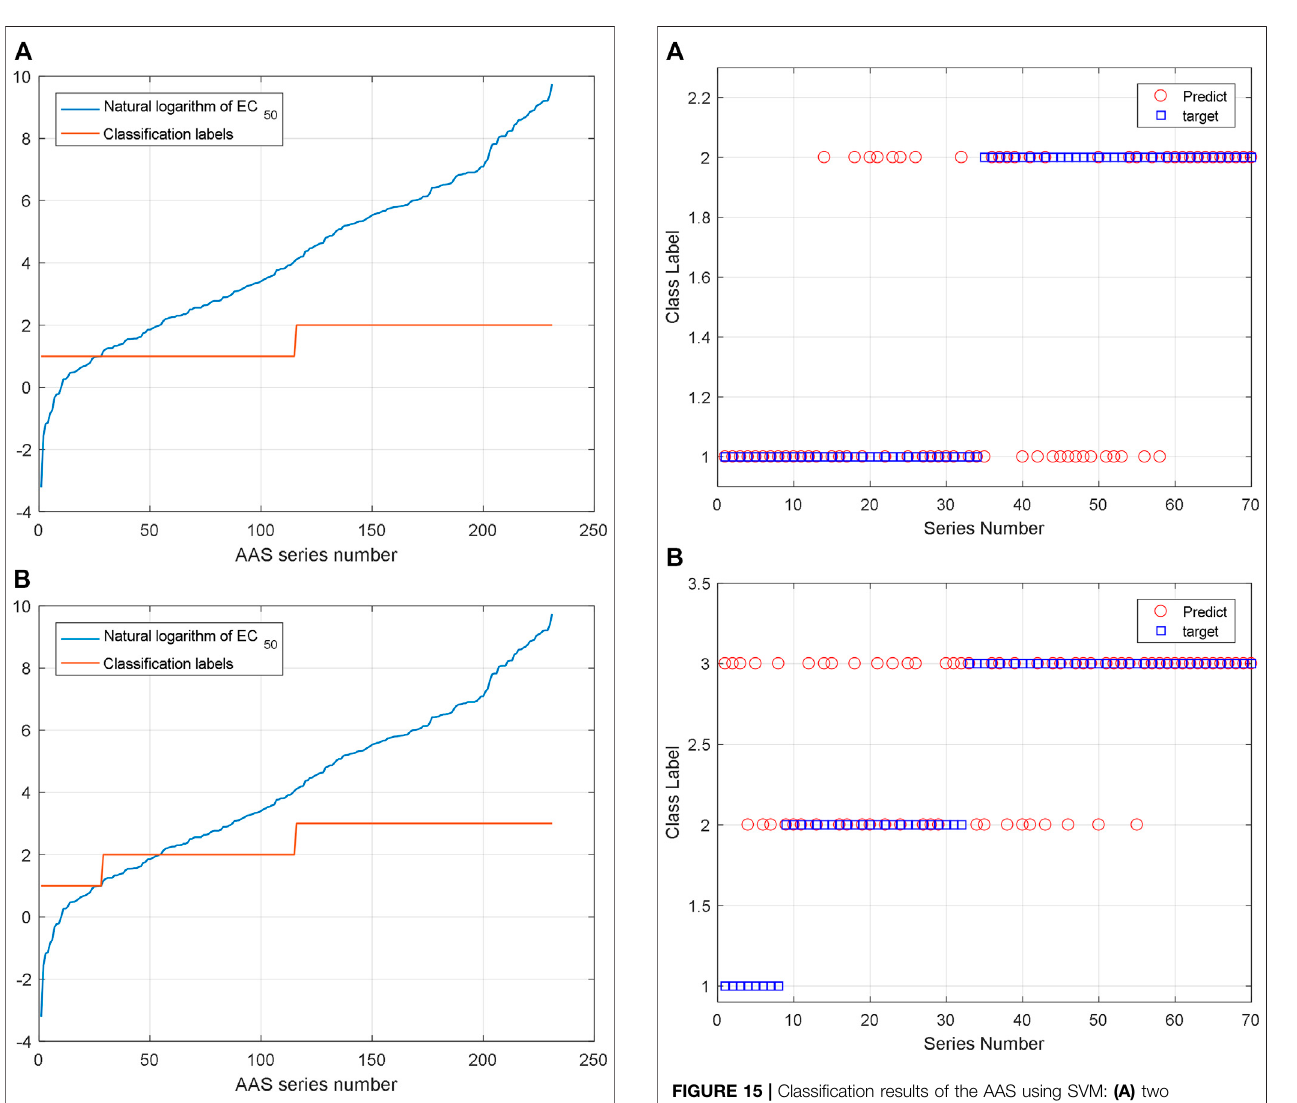
FIGURE 15 | Classi fi cation results of the AAS using SVM: (A) two classi fi cation and (B) three classi fi